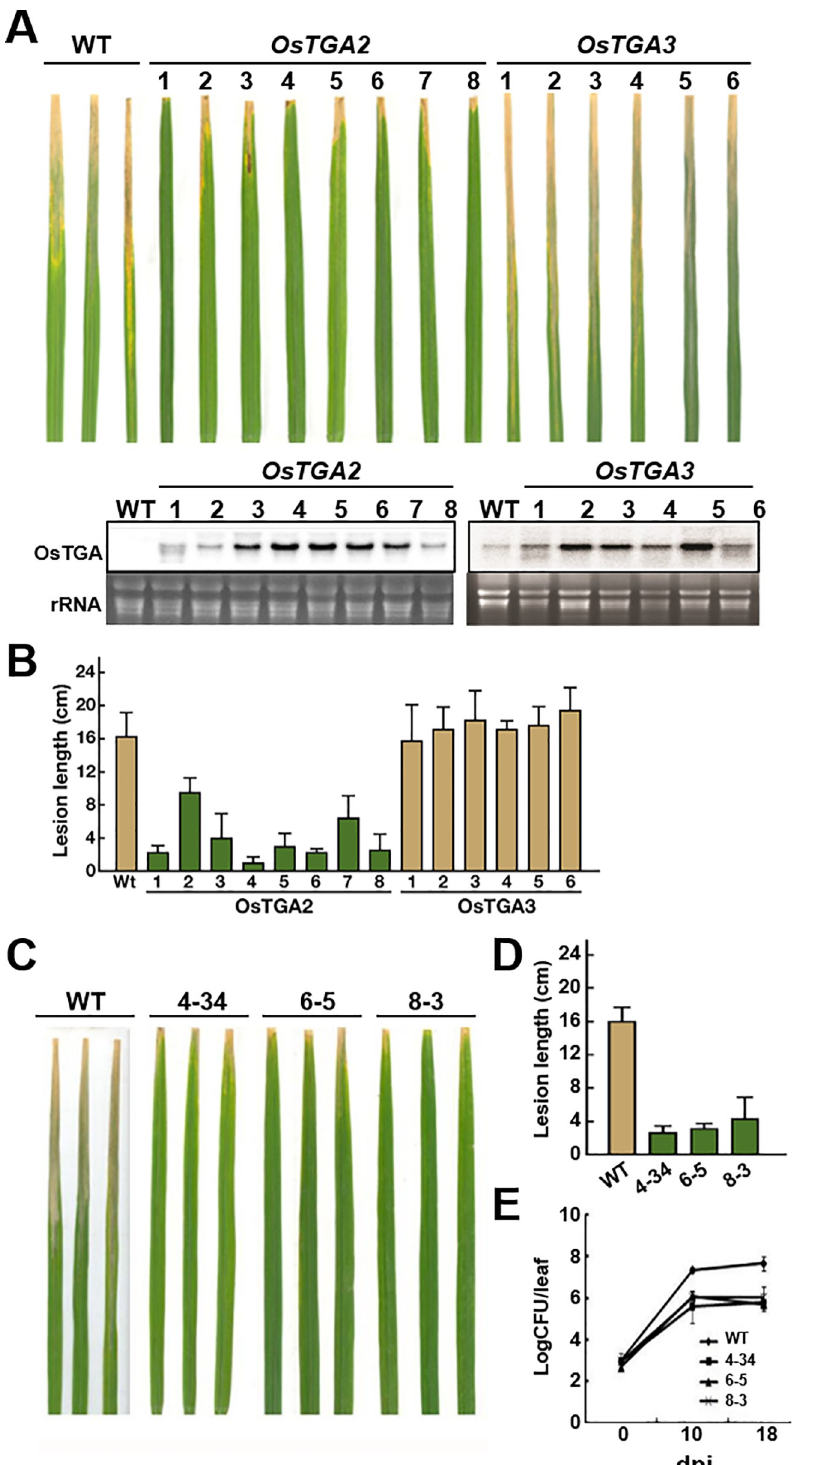
Fig 5. Overexpression of OsTGA2 confers resistance to rice against bacterial leaf blight. (A and B) OsTGA2 and OsTGA3 overexpressing transgenic plants were inoculated with Xoo strain KACC10331 when plants were 6-week old. Northern blotting were done to confirm the overexpression in each lines. Three independent experiments were performed and lesion lengths were measure at 3 weeks after inoculation (B). Pictures were taken 3 weeks